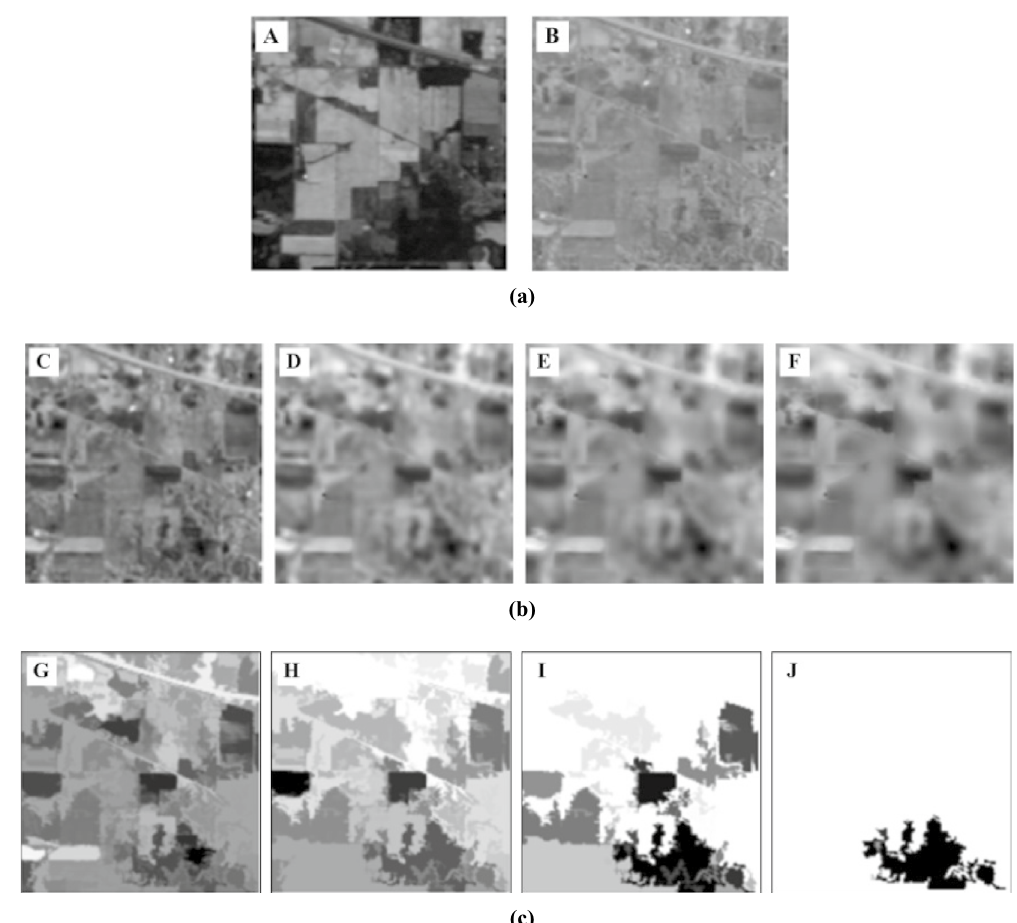
Figure 5. Results of multi-scale features extracted by different methods. ( a ) Dimension reduction results of PCA theory of Indian pines data (A. the first principal component image, B. the second principal component image). ( b ) Multi scale features extracted by MGFEC algorithm (C-F denotes feature maps with scales of 2, 4, 6 and 8 respectively). ( c ) Multi scale features extracted by EMP algorithm (G-J denotes feature maps with scales of 2, 4, 6 and 8